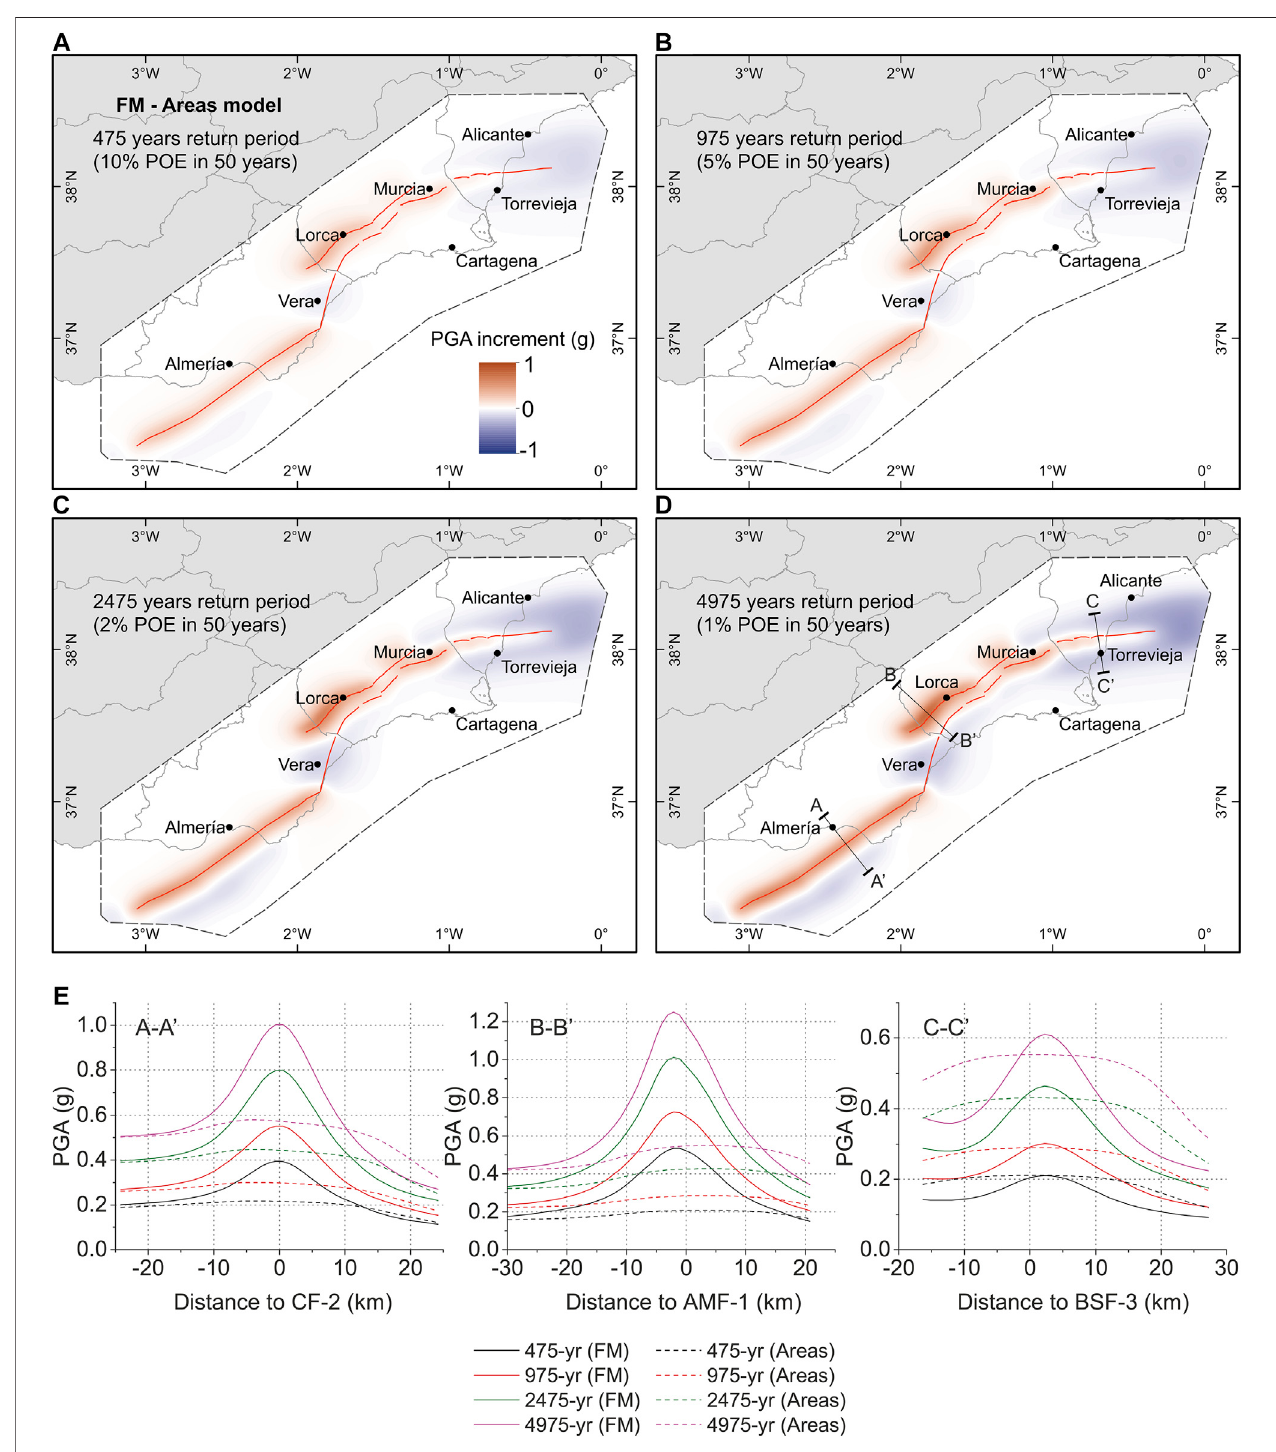
FIGURE9|(A) Difference(ing)ofthemeanhazardmapfromtheFM model( Figure4 )respectivetothemeanhazardmapusingexclusively theZESISareasource model(Areasmodel)andforthereturnperiodsof475 years; (B) 975 years; (C) 2,475 years,and; (D) 4,975 years.ThetracesoftheEBSZfaultsconsideredaredepicted in red. A common color scale is set for all return periods; (E) Cross sections representing PGA values of both FM model (solid line) and Areas model (dashed line) as a function of distance to the surface fault trace and for the same return periods as the maps. The locations of the cross sections are depicted in Figure 9D .